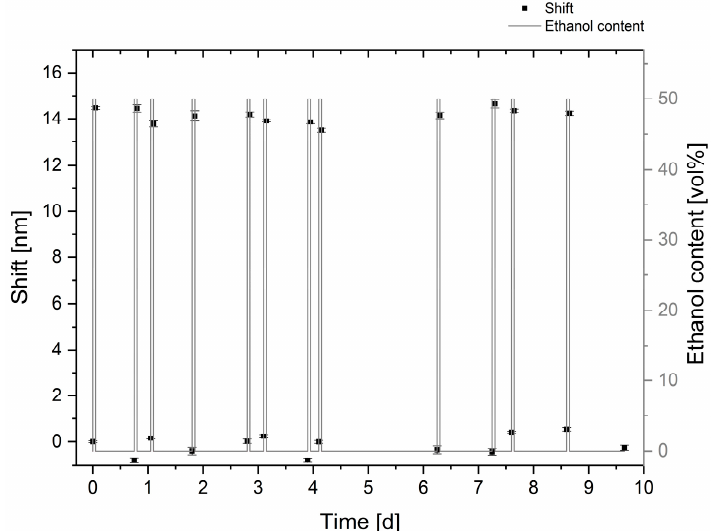
Figure 7. Signal stability of the resonance shift of the sensor substrate, coated with the PAM hydrogel, investigated over 10 days by a periodically induced deswelling in a 50 vol% ethanol solution.